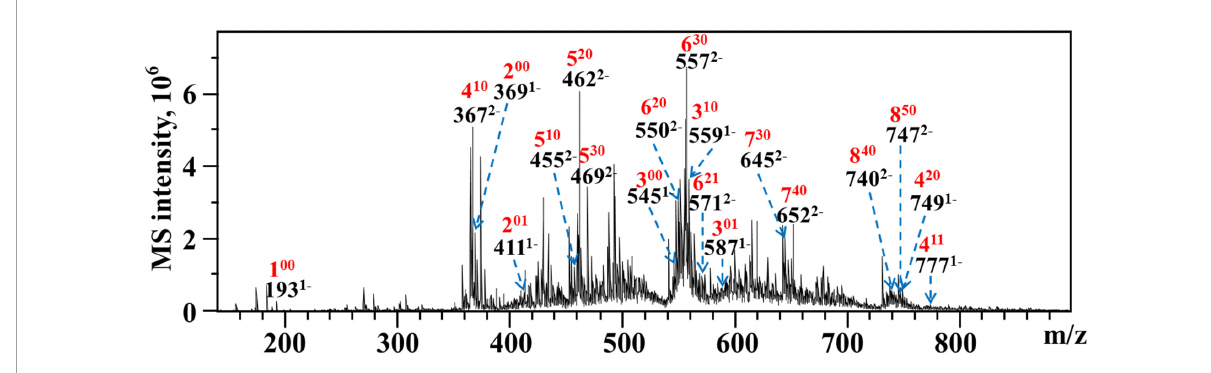
FIGURE5 ESI-MS analysis of WLJP-A0.2b-E3. Peak annotation: 4 20 , DP 4, 2 O -methyl-ester group, 0 O -acetyl